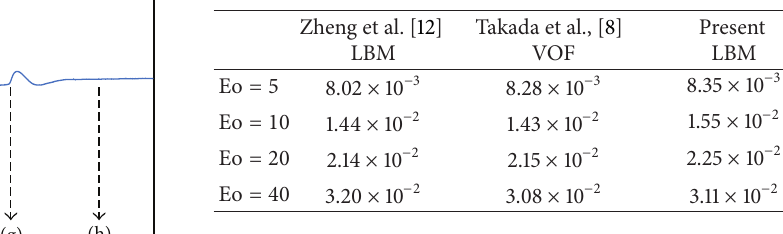
Table 1: Comparison of terminal velocity of a bubble rising under